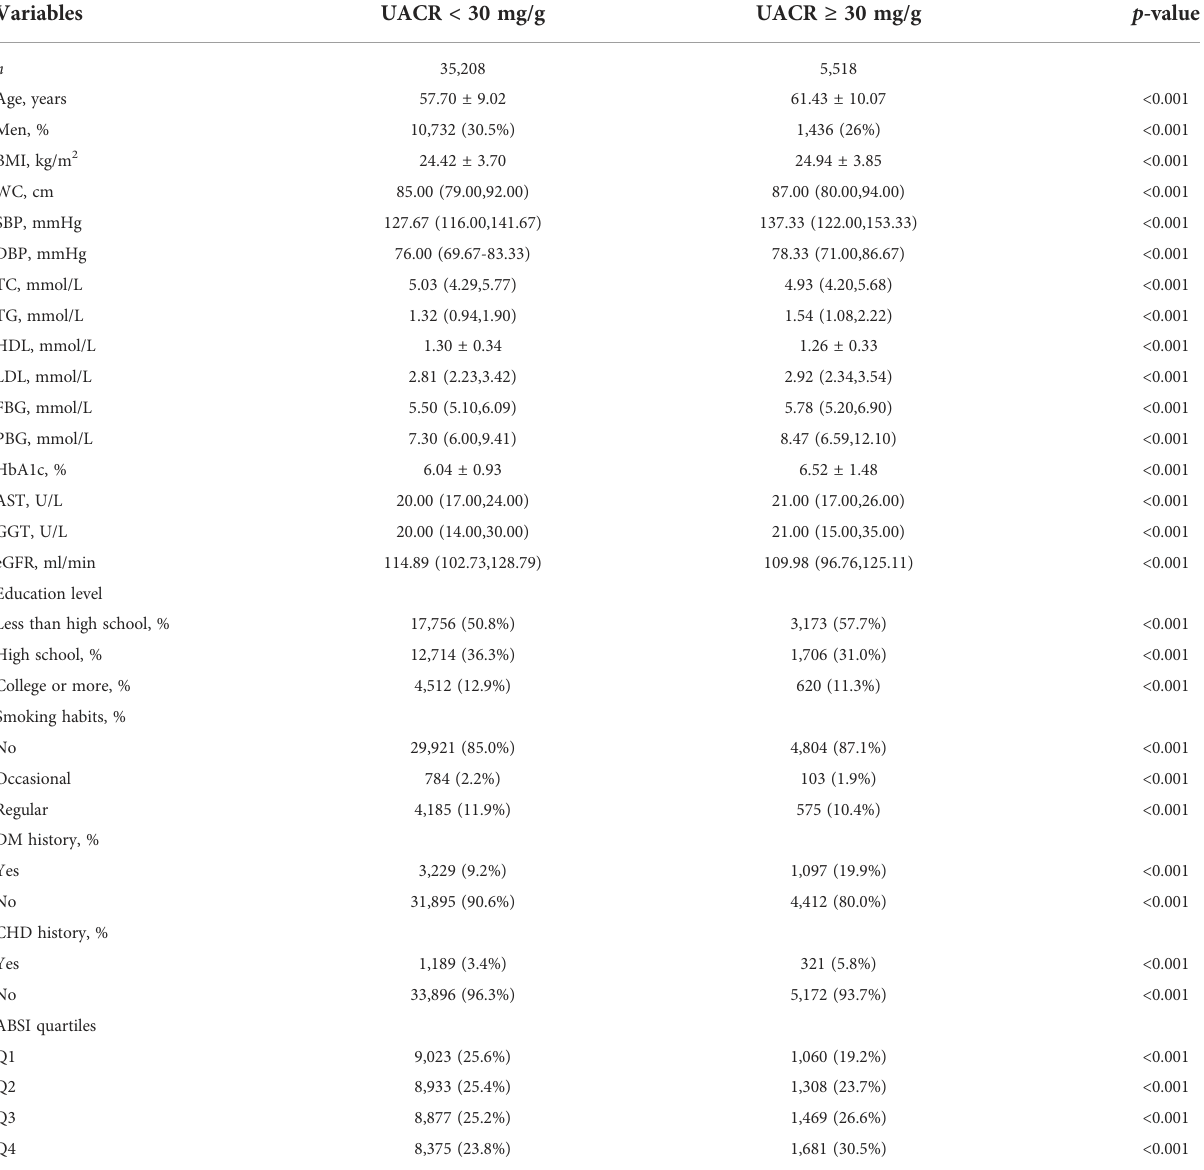
TABLE 1 Characteristics of the study population by UACR category.